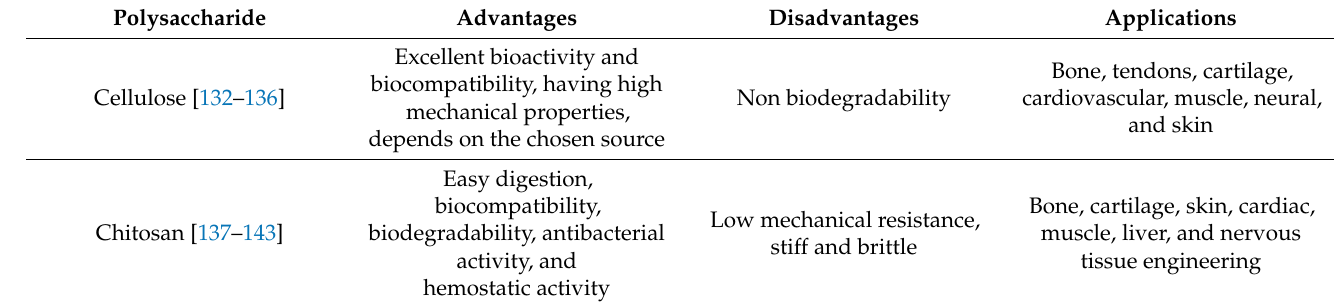
Table 3. Advantages, disadvantages, and applications of polysaccharides in various tissue regen- eration applications.